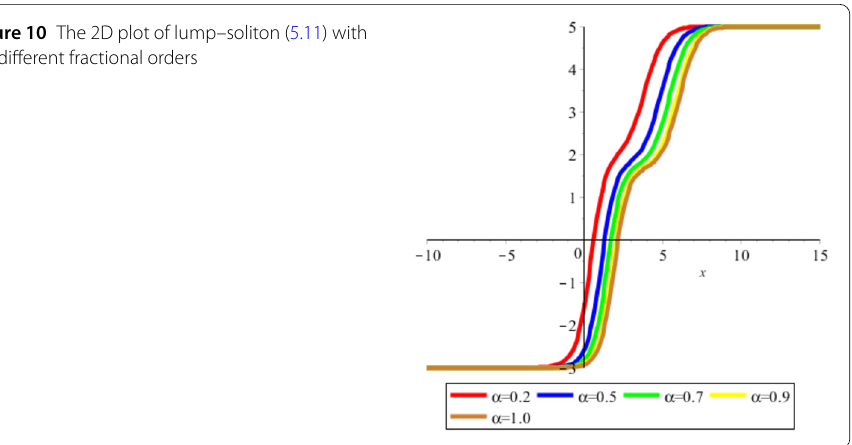
Figure 10 The 2D plot of lump–soliton (5.11) with the different fractional